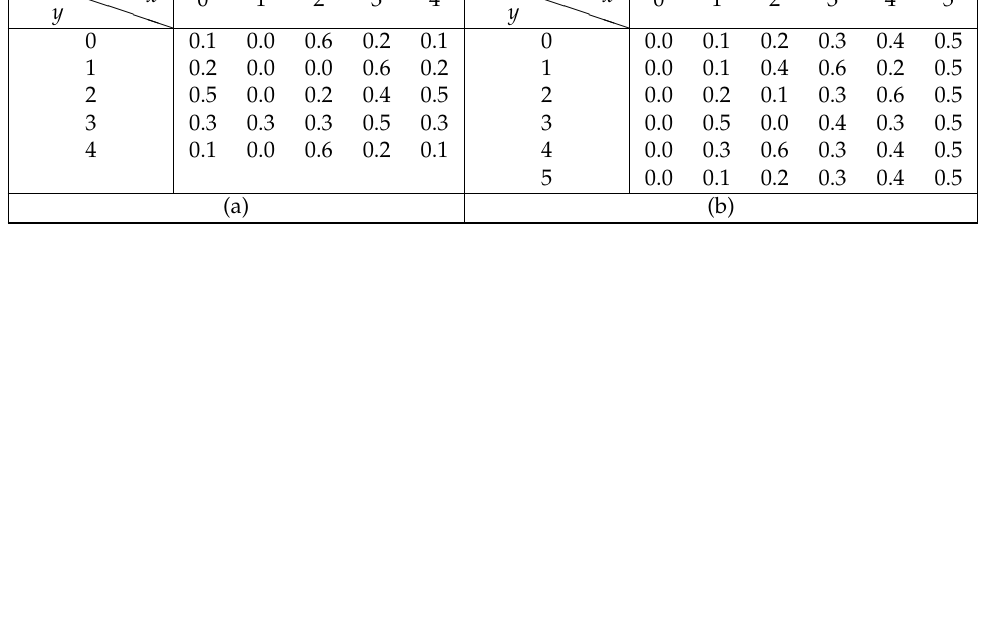
Table 2. (a) The original data used for the fractal surface. (b) The data used for the general construction. (cid:80) (cid:80) (cid:80) (cid:80) (cid:80) (cid:80)(cid:80)